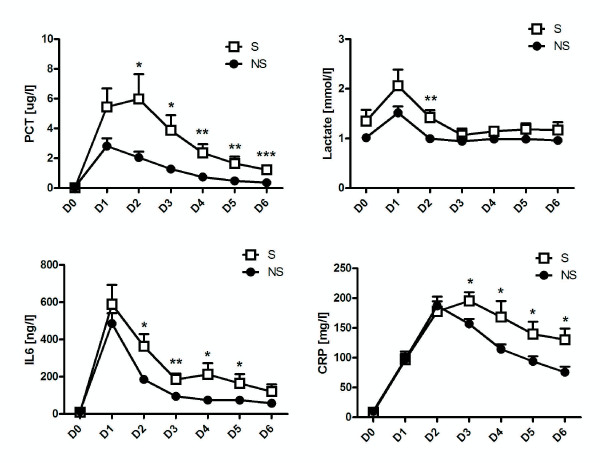
Mean postoperative changes in serum PCT (A); lactate (B); IL-6 (C); CRP (D). Changes from day of surgery (D0) to Day 6 after surgery (D6) in the septic (S) and nonseptic (NS) groups. PCT and IL-6 are statistically significant in the S and NS groups from D2. * indicates p < 0.05. ** indicates p < 0.01. ***indicates p < 0.001.